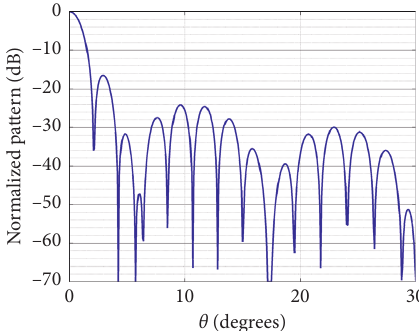
Figure 6: The array factor for N � 64 and M � 44. The 5 th and 6 th SLLs are approximately equal.